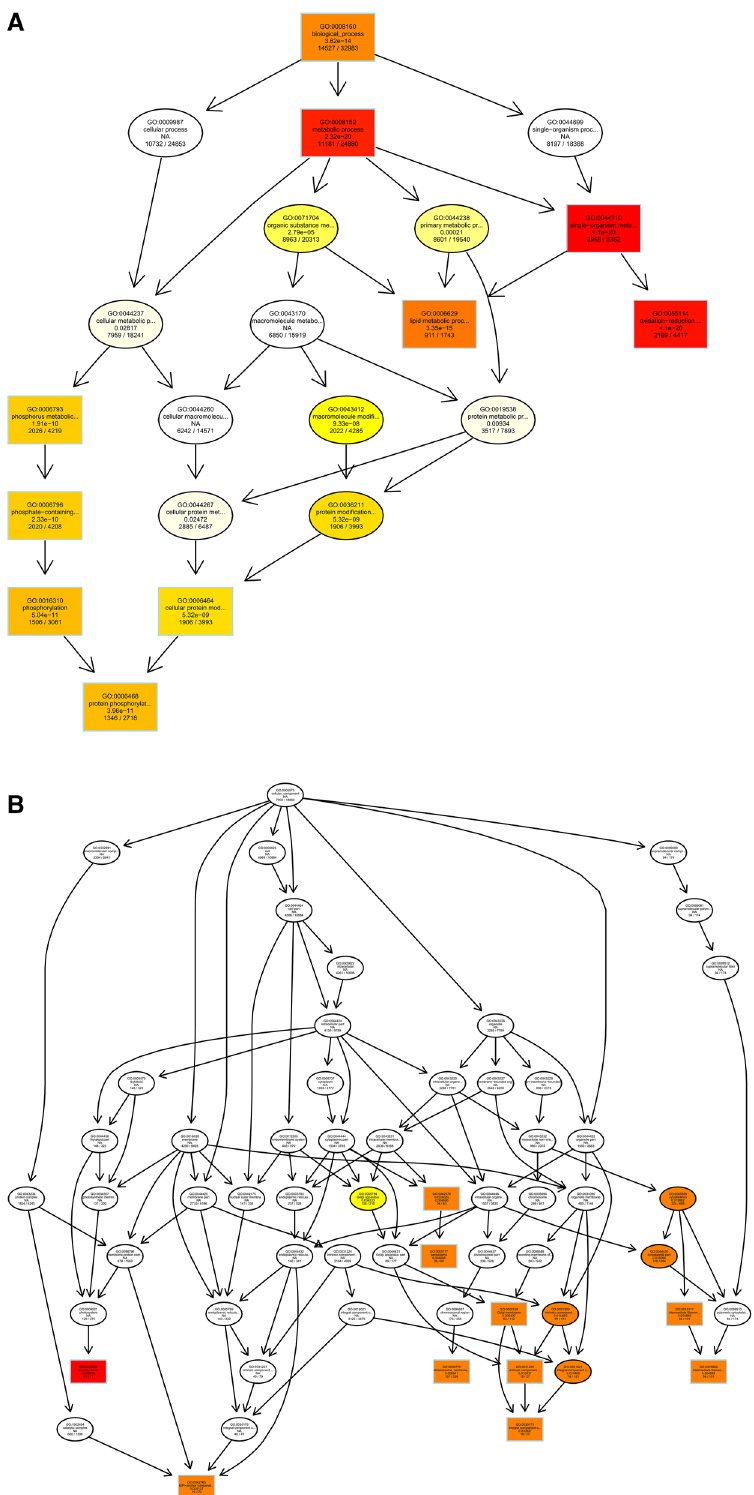
Figure 6. Differentially expressed lncRNAs in ginseng tissues predicted the GO enrichment analysis of target genes according to the expression correlation. ( A ) The directed acyclic graph of the BP part; ( B ) the directed acyclic graph of the CC part; ( C ) the directed acyclic graph of the MF part; ( D ) statistical histogram. Image generated with R 3.6.3 (https:// www.R- proje ct. org) 51 ggplot2 package (https:// ggplo t2. tidyv erse.